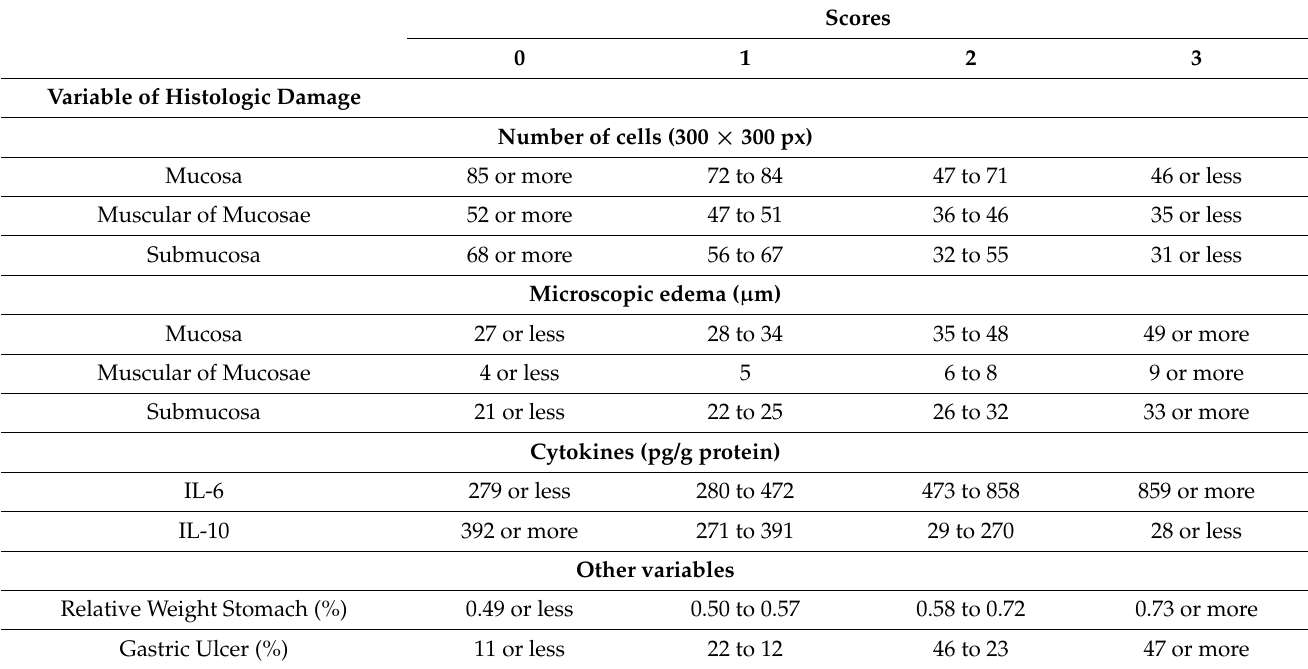
Table 3. Score values associated with damage variables in gastric ulcers induced with